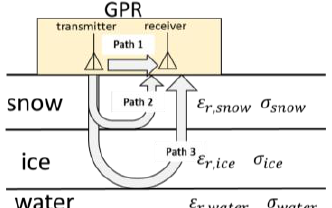
Figure 1. Skematic view of ice thickness measurement.